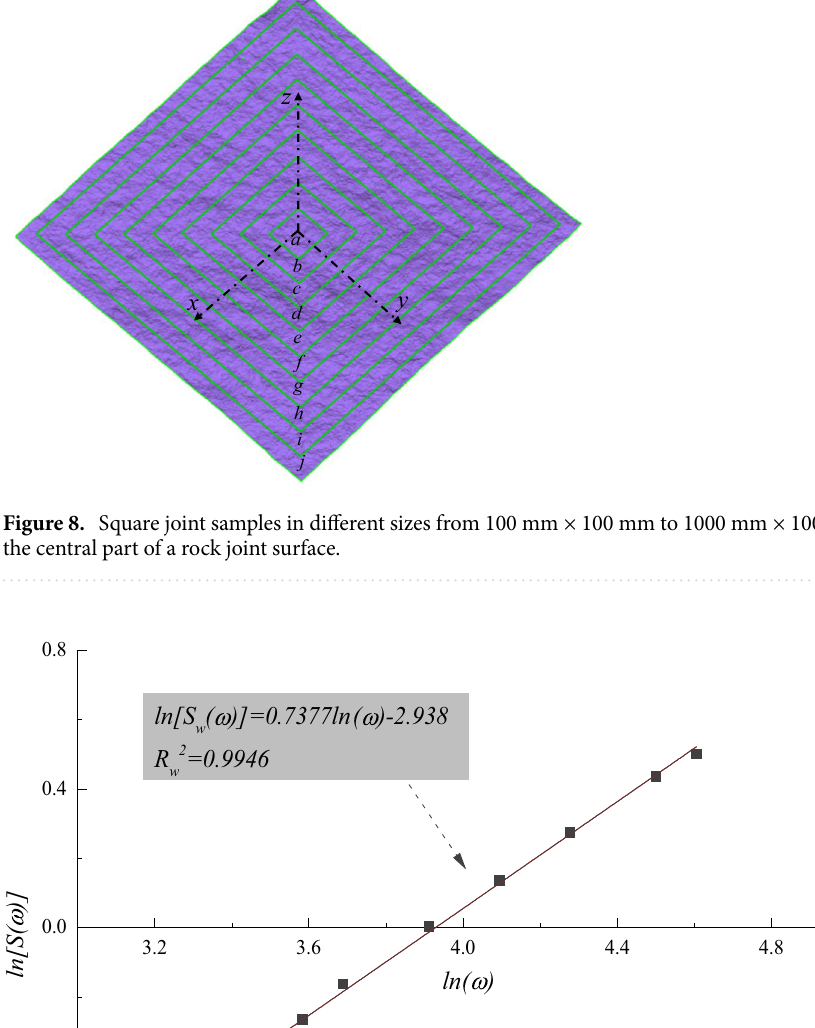
2 R 2 w and u are the